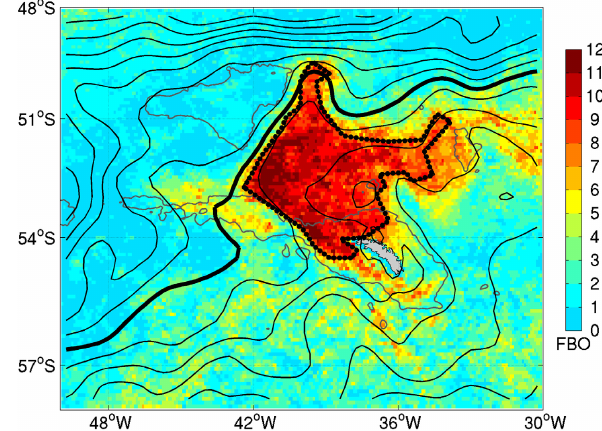
Fig. 5. Phytoplankton bloom occurrences in the South Geor- gia region obtained from SeaWiFS estimates and calculated for austral summer (December–February, from 1997–2010). Colour indicates the frequency of occurrence of bloom conditions (Chl a ≥ 0.75mgm − 3 ) . Regions coloured in shades of red corre- spond to pixels where summer blooms have been recorded at least 8 times out of the 12 sampled seasons while regions in shades of blue indicate more rare bloom events. Black lines correspond to Aviso dynamic topography isopleths for the summer climatology (December–February, from 1997–2010); isopleths are drawn ev- ery 10dyncm. For reference, the bold black line corresponds to − 71dyncm, and is indicated by Venables et al. (2012) as the south- ern limit of the Polar Front. The polygon drawn with a dotted black line indicates the extension of the typical bloom area. The 2000m bathymetry contour is also